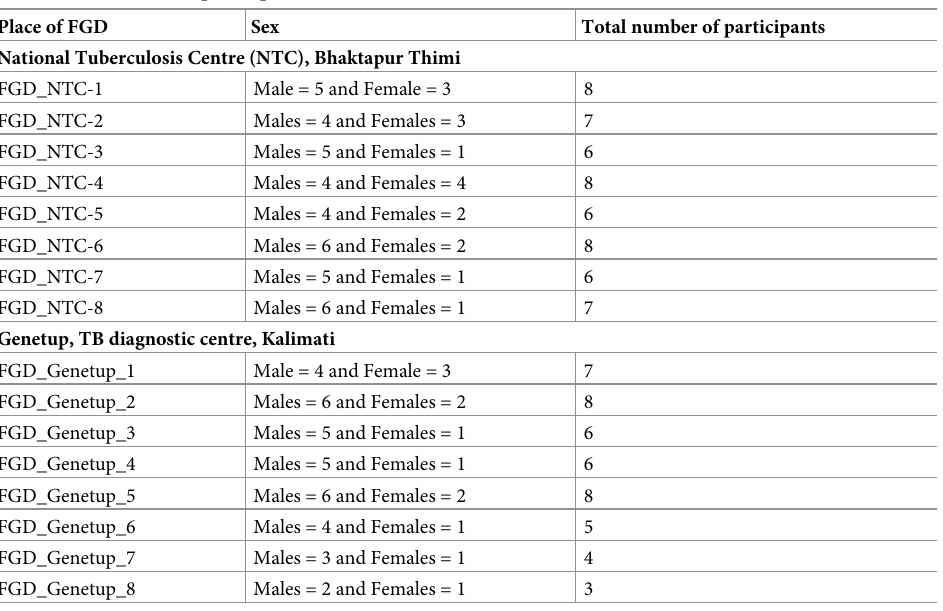
Table 6. FGD for TB suspected patients. Place of FGD Sex Total number of